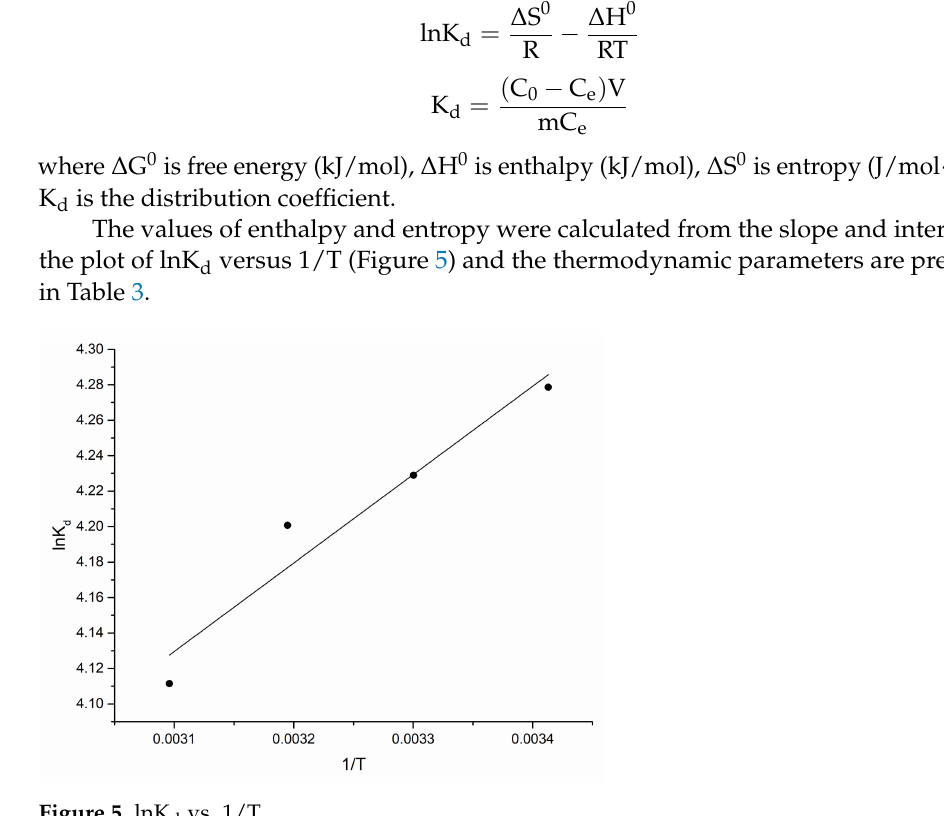
Figure 5. lnK d vs. 1/T. Table 3. Thermodynamics parameters of Er(III) biosorption on A. platensis . Temperature,